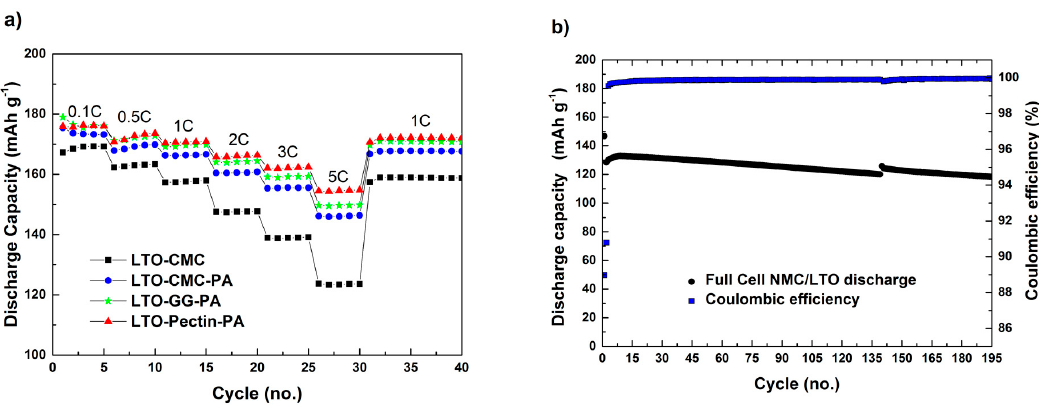
Figure 5. Delivered discharge capacity of ( a ) LTO half-cells using CMC as the binder and CMC, pectin and GG as the binder and PA as an additive at several current densities; LTO mass loading: 3.6–4.1 mg·cm − 2 ; electrolyte: 1 mol of LiPF 6 in ethylene carbonate and dimethyl carbonate (EC:DMC